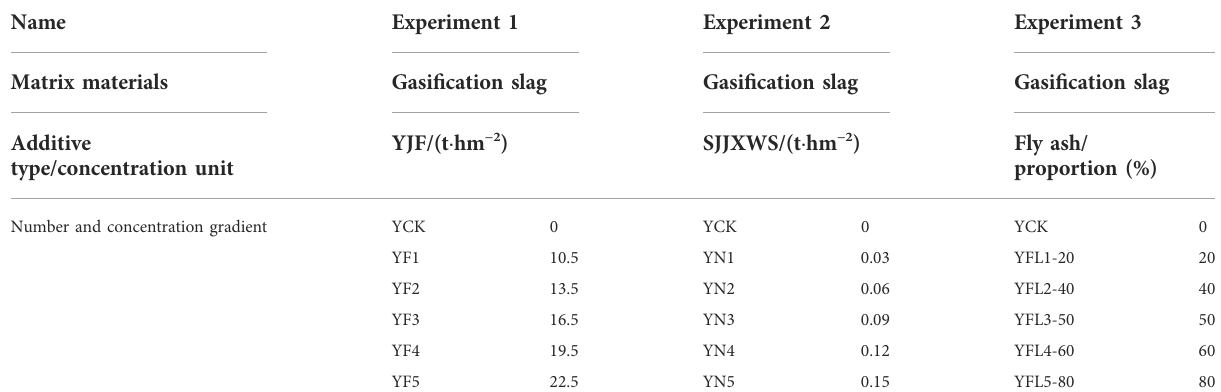
TABLE 3 Experimental